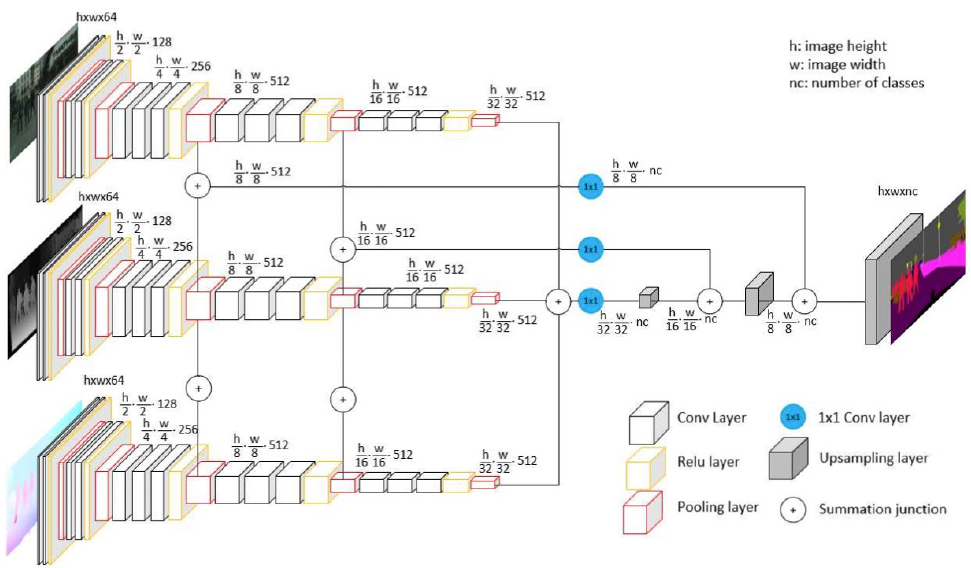
Figure 11. Architecture of [108] where the parallel, multimodal architecture is reported. Reprinted with permission from [108]. Copyright 2019,